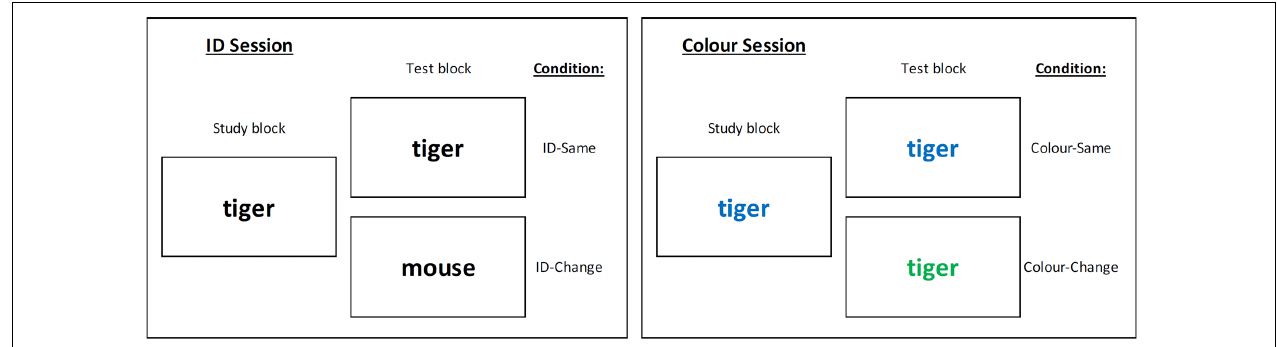
FIGURE 1 | A schematic representation for the ID and color sessions in the word classification task in Experiment 1. The allocation of words to condition and the order in which the words were presented within each of the study and test blocks was randomized. Note that the identity of the stimuli in the color session was always the same between the study and test blocks regardless of whether there was a change in color between the two blocks.